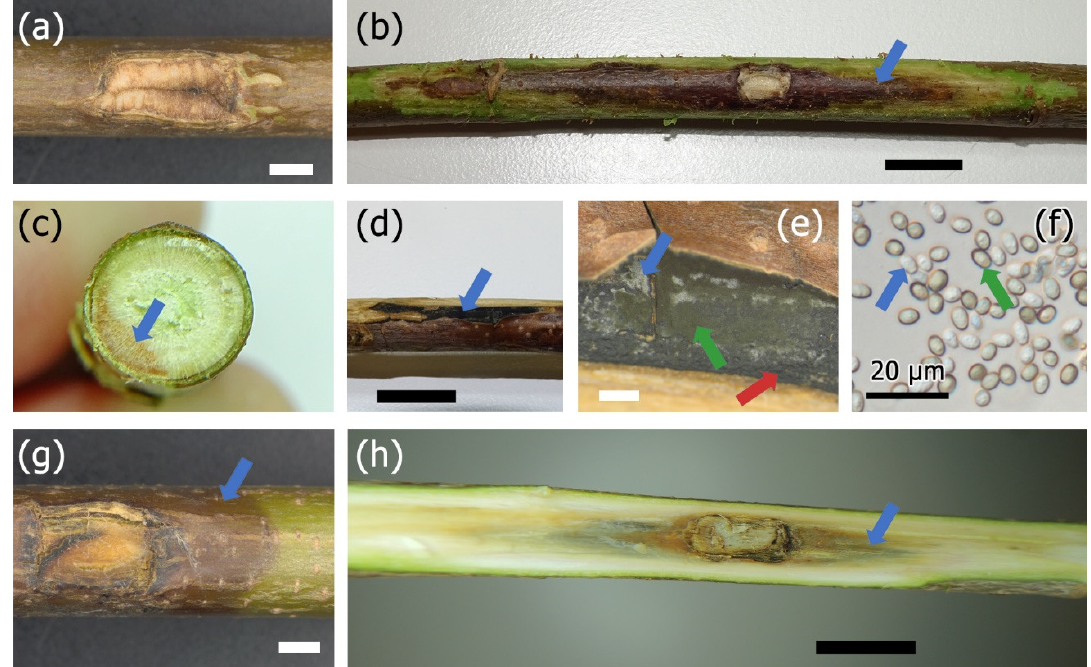
Figure 5. Pathogenicity tests of Cryptostroma corticale on Acer pseudoplatanus after 38 days at 25 °C under two watering treatments: ( a ) Healed control; ( b ) necrosis in the bark of a sapling under the drought treatment, marked by the blue arow; ( c ) discoloration of the sapwood, marked by the blue arow; ( d ) conidiomata under the bark of a sapling under the drought treatment, marked by the blue arow; ( e ) black areas of stroma (red arrow), whitish areas with a layer of conidiogenous cells (blue arrow), brownish areas with masses of conidia (green arrow); ( f ) masses of ovoid, young hyaline (blue arrow), and darker brown older conidia (green arrow); ( g ) lesion in the bark of a sapling under the humid treatment, marked by the blue arow; ( h ) discoloration of the wood, marked by the blue arow. White bar = 2 mm, black bar = 1 cm.